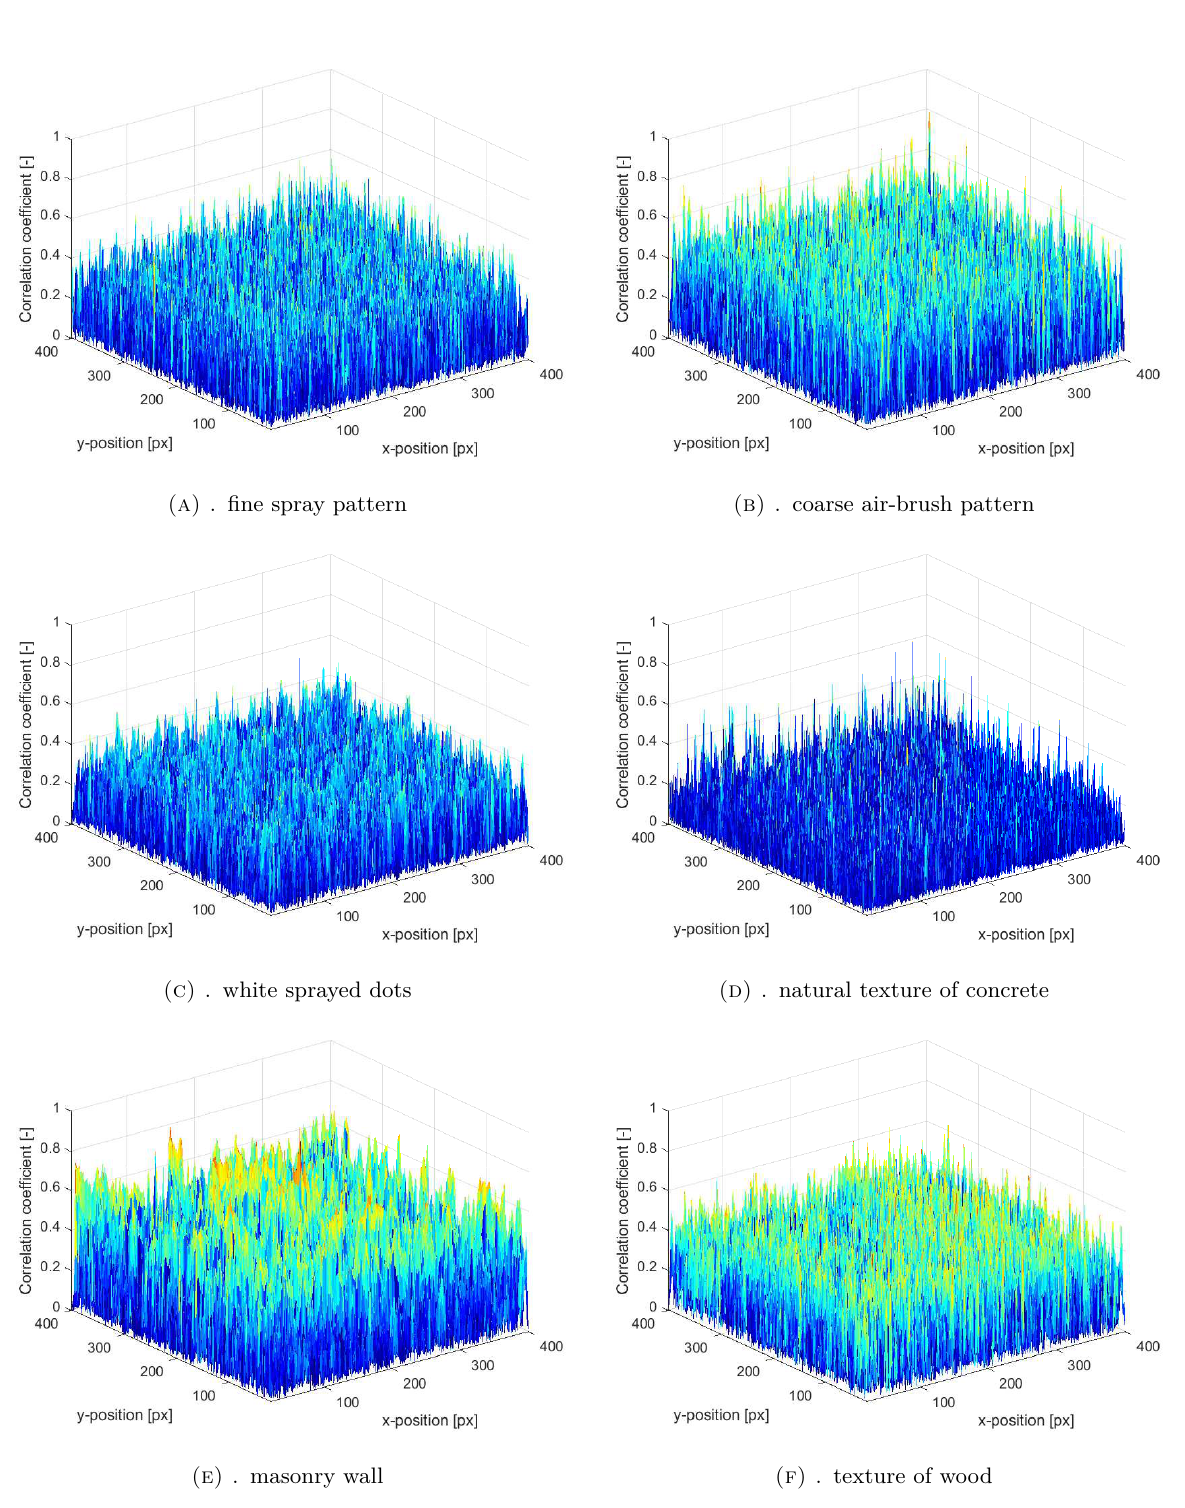
Figure 3. Correlation function values for 10 × 10 px subset